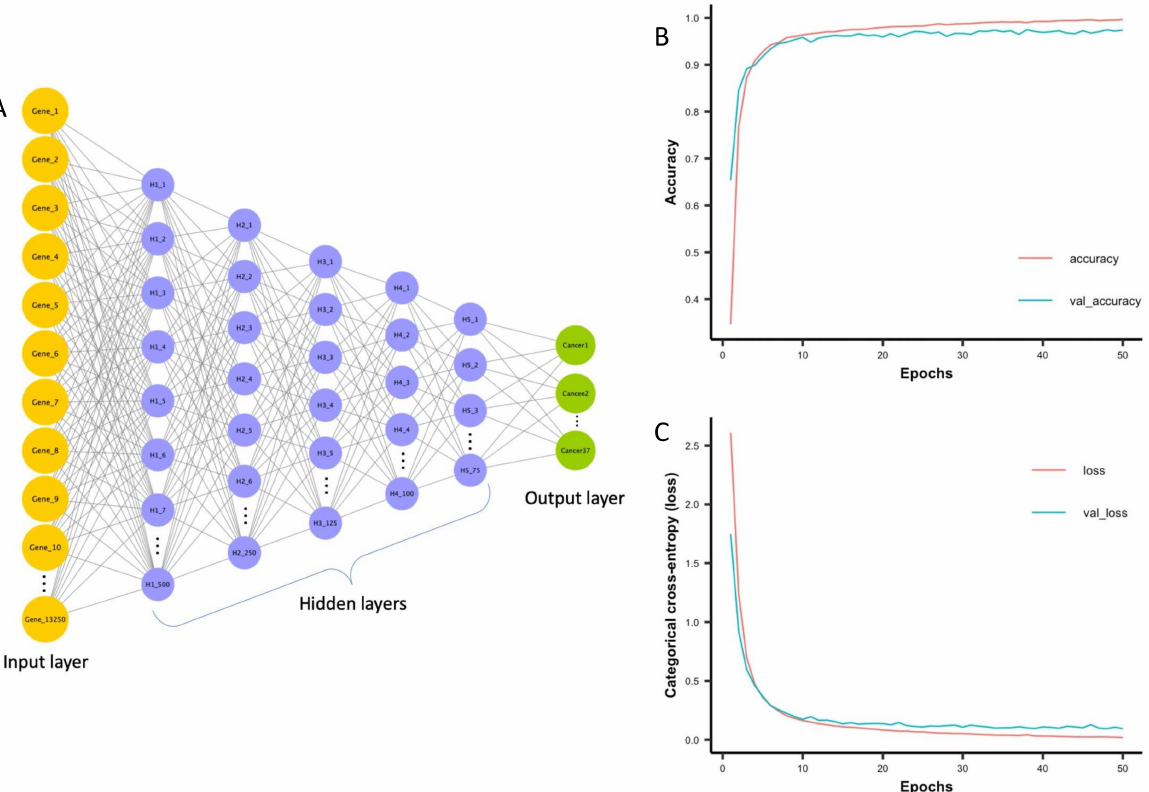
Figure 2. Architecture of deep neural network model and its progress during training. ( A ) The deep neural network model consists of an input layer, five hidden layers and an output layer. The input layer takes input fragment per kilobase per million mapped fragments values for 13,250 genes. Hidden layers perform nonlinear transformation using rectified linear unit activation function to distinguish between cancer types. There are 5 hidden layers with 500, 250, 125, 100 and 75 nodes. The output layer consists of 37 nodes each representing one of the cancer types. ( B ) The accuracy and ( C ) Categorical cross-entropy (loss) of deep neural network model on both training and validation data